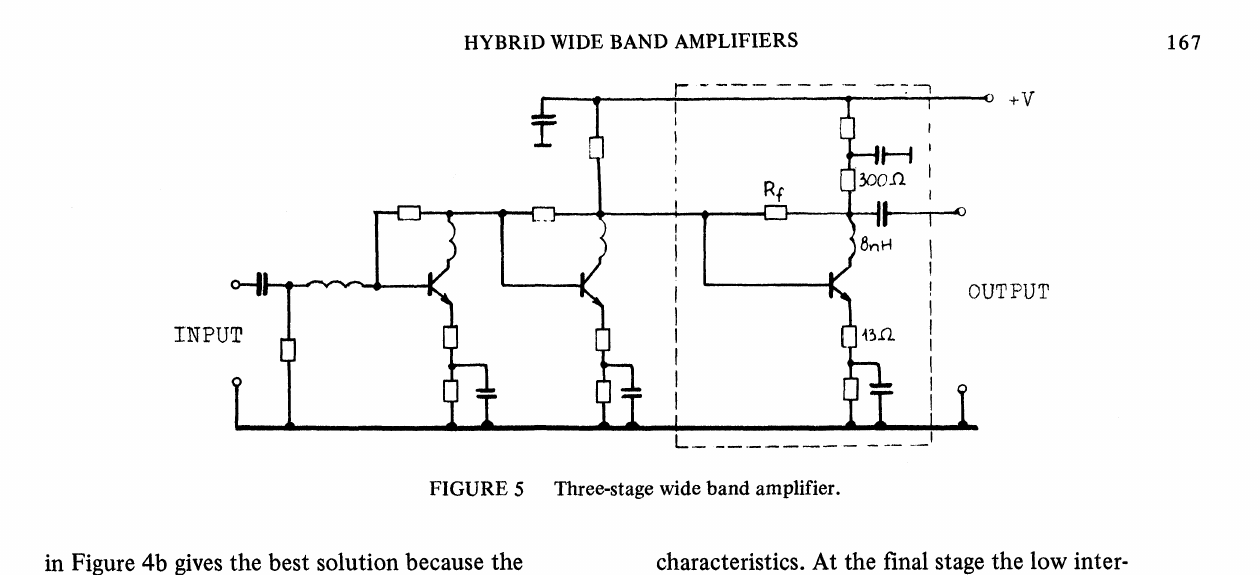
FIGURE 5 Three-stage wide band